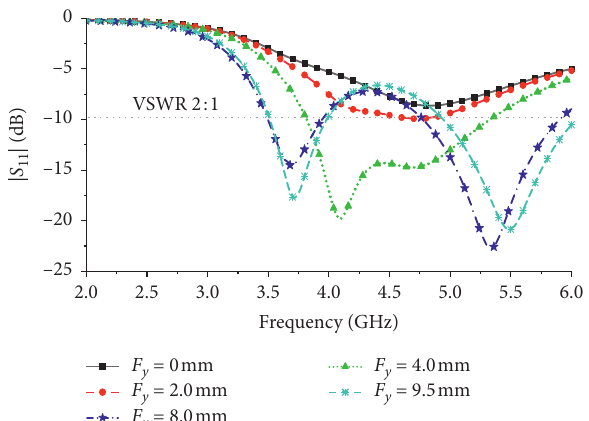
Figure 2: Variation of | S 11 | for Design 1 with respect to F y .